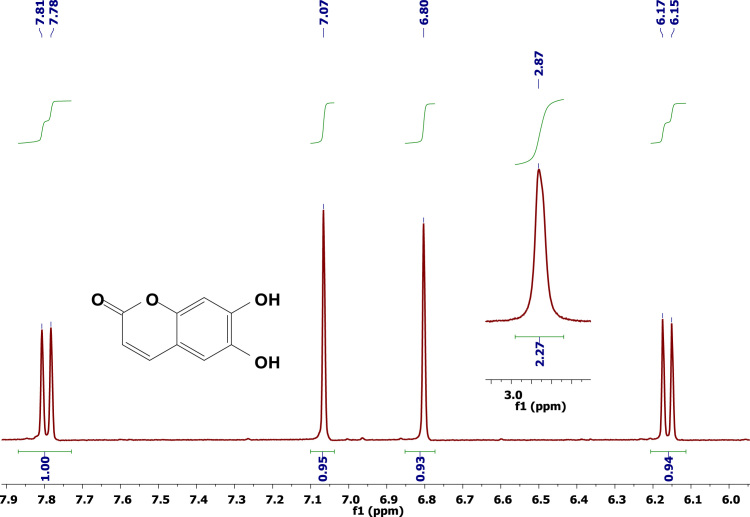
1H-NMR spectrum of Aesculetin (acetone-d6, 298 K, 400 MHz).